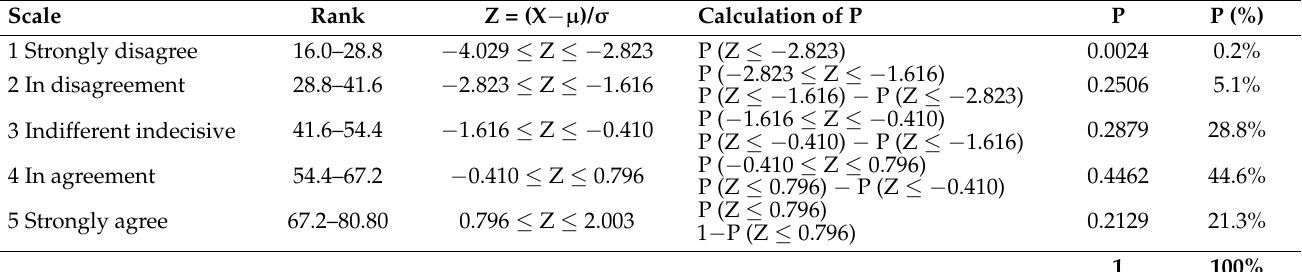
Table 2. Typification of variables X and calculation of probability according to the normal distribution. (Source: self made).